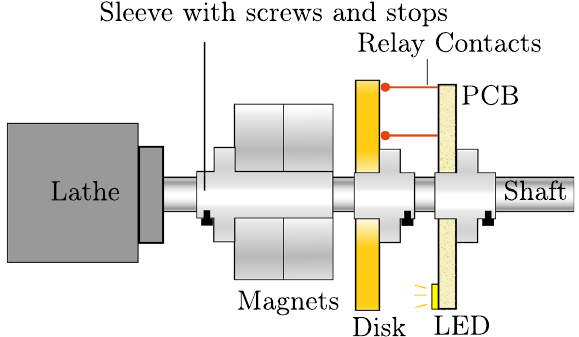
Figure 2. Sketch of the experimental